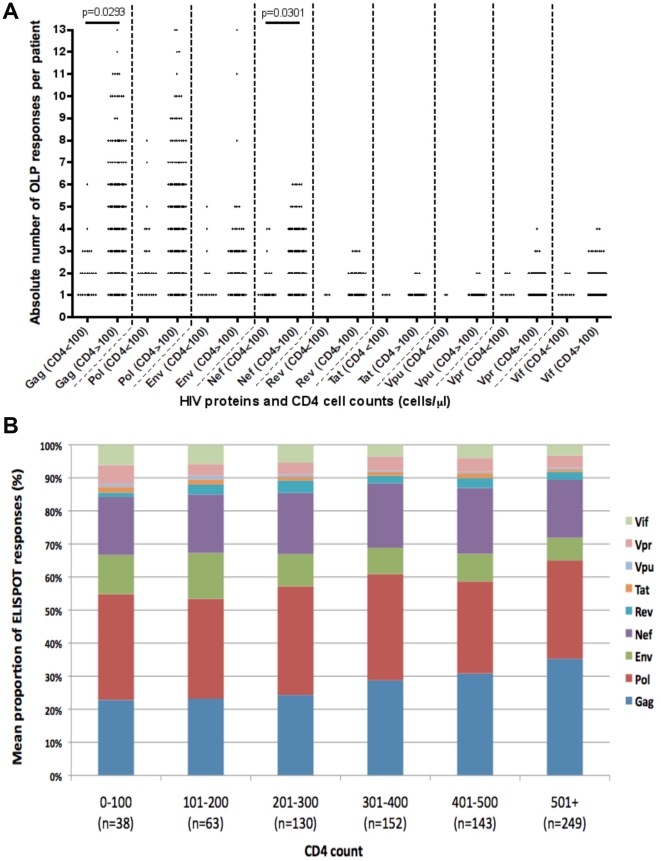
Gamma interferon ELISPOT responses in patients with CD4 counts above
and below 100 cells/µl.Recognition of overlapping peptides covering the full HIV genome is shown
in patients with CD4 cell counts above and below 100 cells/µl.
ELISPOT responses are displayed as (a.) the absolute breadth of
responses, reflecting the mean number of overlapping peptides recognised
by each patient for each HIV protein and, (b.) the relative breadth,
reflecting the proportion of ELISPOT responses targeted against
different HIV proteins in patients within different CD4 count
strata.